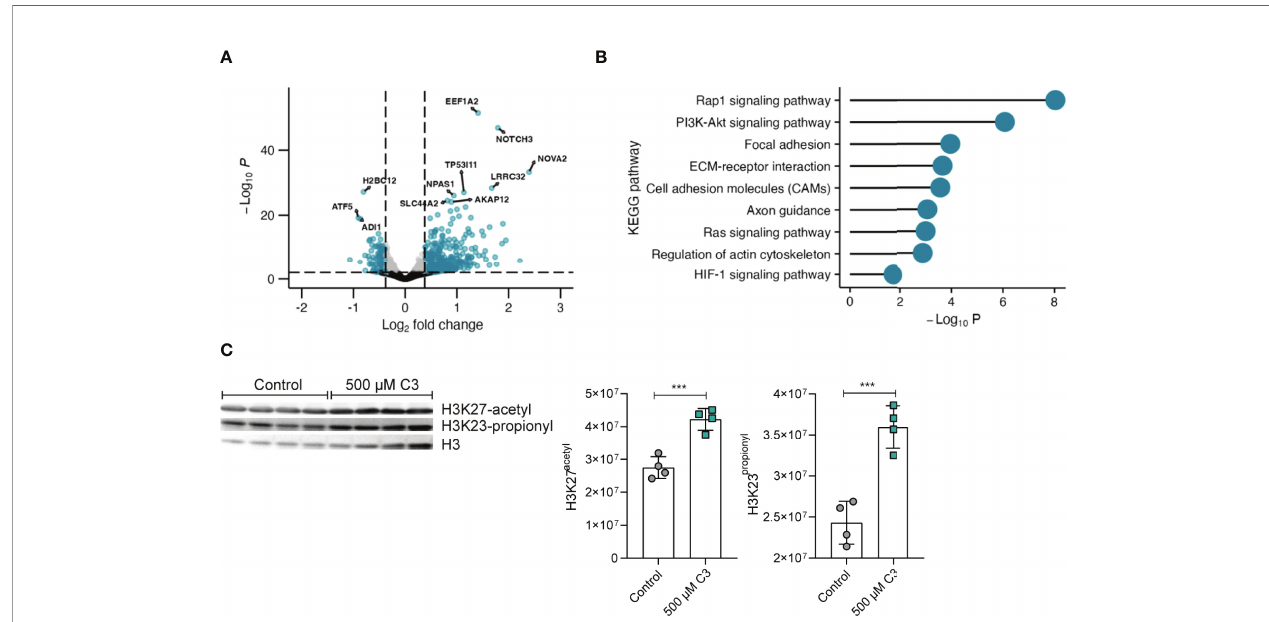
FIGURE 3 | C3 signi fi cantly upregulates expression of genes involved in megakaryocyte maturation. (A) Volcano plot of fold change (FC) values of mRNA sequencing RNAseq analysis from Meg-01 cells treated with 500 m M C3 compared to non-treated cells (control). n = 3 technical replicates. Gates were set at an adjusted p-value < 0.01 and a fold change > 30% and depicted as log2 fold change. Genes marked in blue display genes above log2 fold change gate and p-value gate. Grey dots display genes below the log2 fold change gate and above the p-value gate. Black dots display genes below the log2 fold change and p-value gate. (B) KEGG pathway analysis of the upregulated differential expressed genes (DEGs) identi fi ed from comparison of Meg-01 cells cultured in 500 m M C3 vs. untreated cells (Control). DEGs were fi ltered on adjusted p-values lower than 0.01 and fold changes greater than 30%. (C) Western blot analysis of H3 histone acetylation and propionylation of Meg-01 after stimulation with 500 µM C3. Untreated cells (only medium) served as negative controls (n ≥ 3 technical replicates). Data are expressed as the mean ± sd. Statistical difference was determined by ordinary one-way ANOVA. ***p <